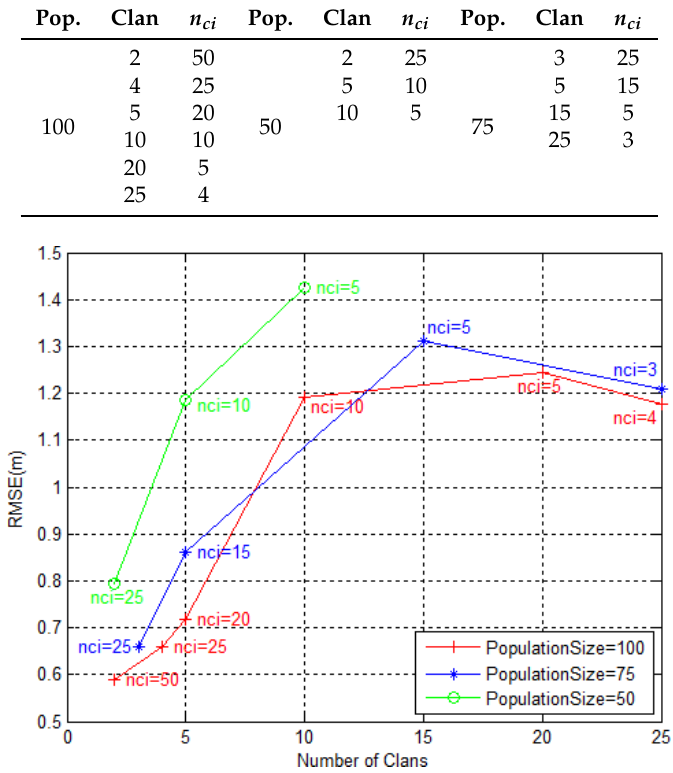
Figure 6. RMSE (m) dependency on the number of clans and n c